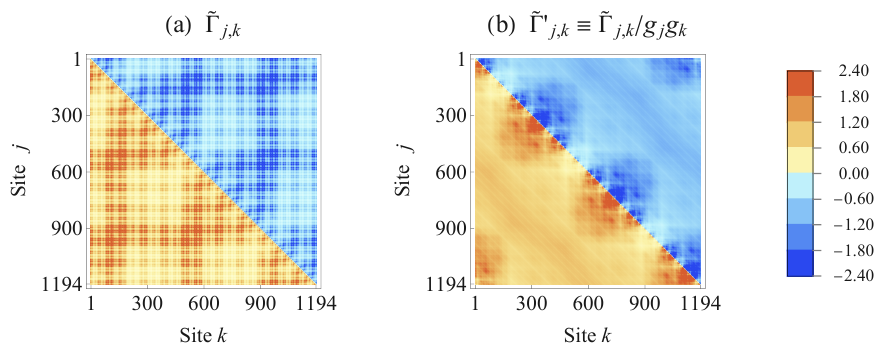
Figure 17 . Decay-adjusted covariance matrix ˜Γ of the { 3 , 7 } MTN boundary state for a non-Ising bulk input a = 0 . 3 . (a) Original covariance matrix with disordered correlation pattern. (b) Nearly translation-invariant matrix ˜Γ 0 after applying a disorder vector g on every site. Deviations from translation invariance are stronger than in the critical Ising case of figure